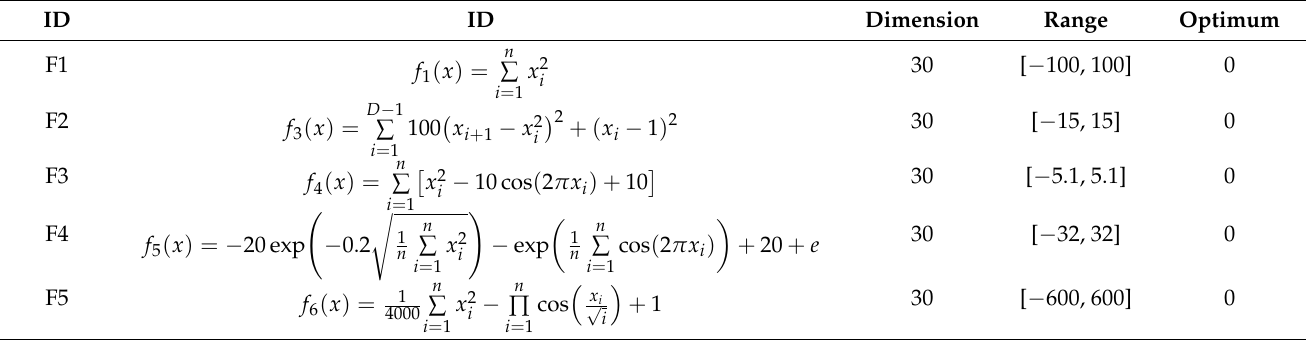
Table 3. Benchmark